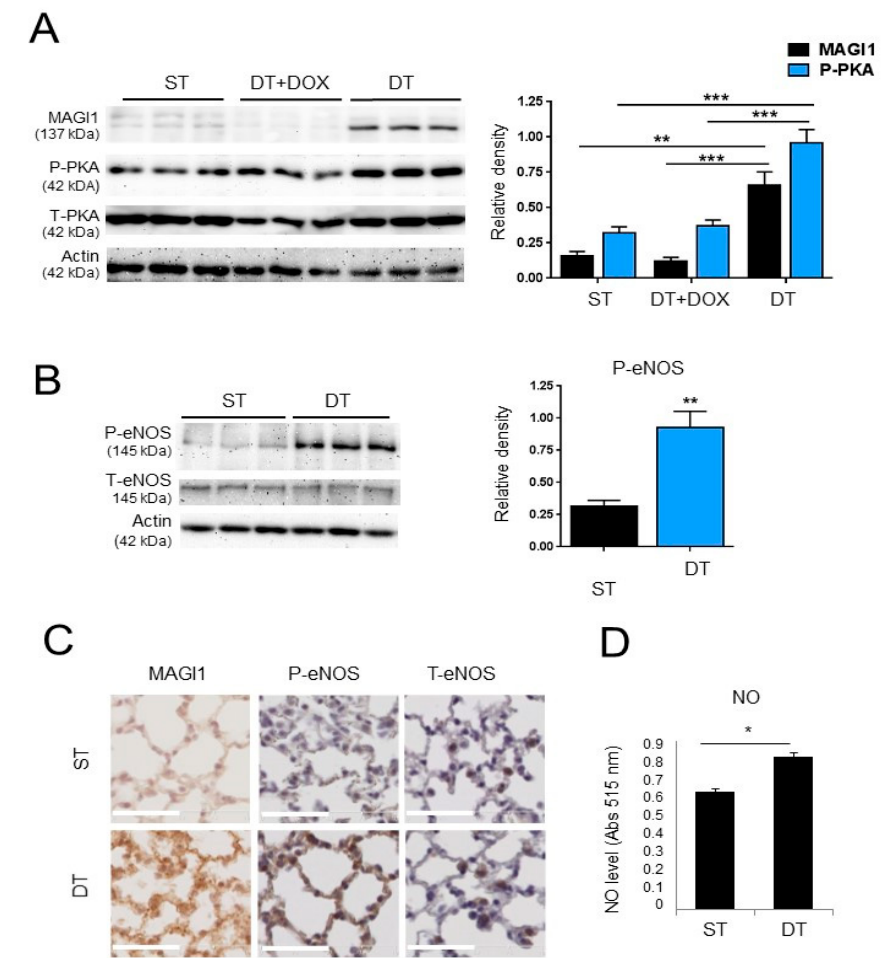
Figure 5. Transgenic expression of MAGI1 in endothelial cells promotes phosphorylation of PKA and eNOS and stimulates NO production. ( A ) Western blotting analysis of total and phosphorylated PKA (Thr 197 ) in lung endothelial cells isolated from ST and DT transgenic MAGI1 mice cultured for 3 days in the absence or presence of doxycycline (dox) as indicated. Doxycycline represses MAGI1 expression and PKA phosphorylation. Triplicate mice, N = 3. ( B ) Western blotting analysis of lung endothelial cells isolated from ST and DT mice for phosphorylated Ser 1177 eNOS (P-eNOS) and total eNOS (T-eNOS). DT lung endothelial cells have elevated eNOS phosphorylation. N = 2, triplicate mice (six independent cultures). Beta actin is shown as loading control. Relative band quantifications by densitometry of multiple experiments are shown next to the blots. ( C ) Lung sections from ST and DT MAGI1 mice were stained for MAGI1, phosphorylated Ser 1177 eNOS (P-eNOS) or total eNOS (T-eNOS). Increased P-eNOS staining (brown) is visible in DT mice. Scale bar = 50 µ m. ( D ) Analysis of NO production by DAF-2DA staining and fluorimetric measurement in lung endothelial cells isolated from. N = 3, triplicate conditions each. ST, single transgenic mice; DT, double transgenic mice. * p < 0.05; ** p < 0.01; *** p < 0.001.